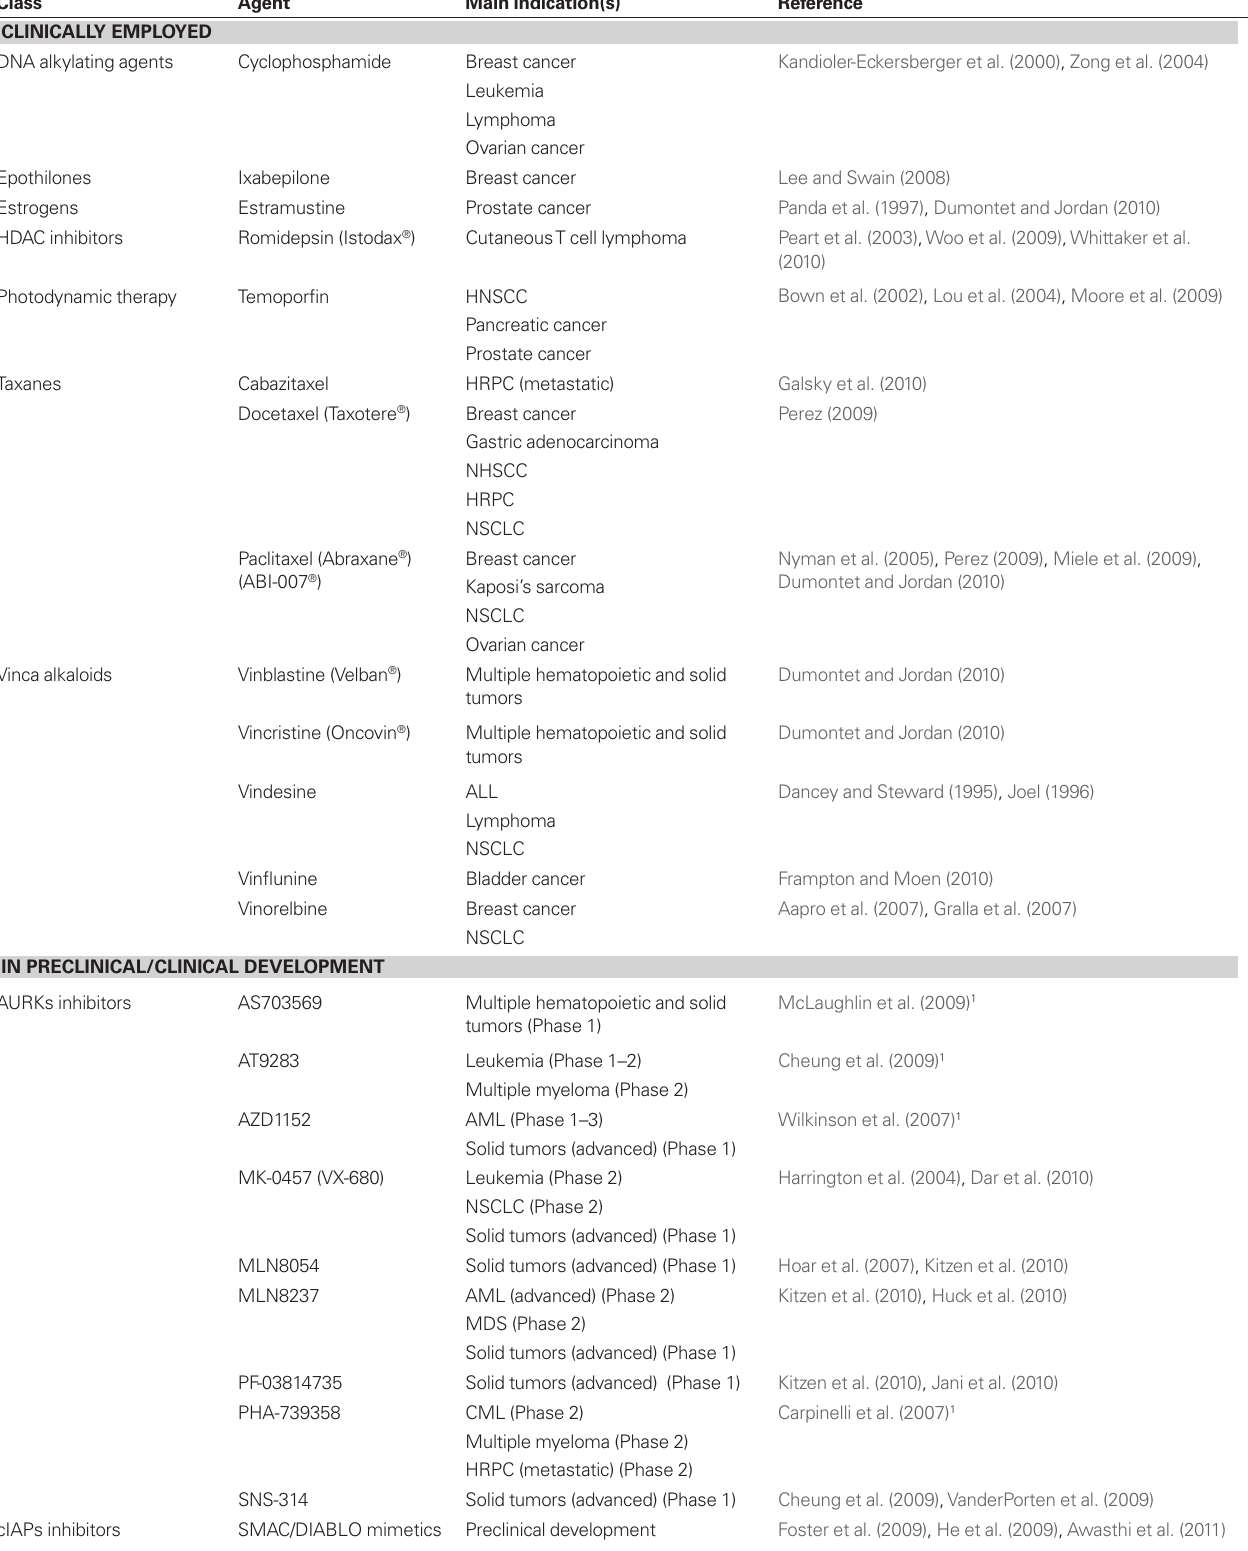
Table 3 | Examples of anticancer agents that ignite programmed necrosis or mitotic